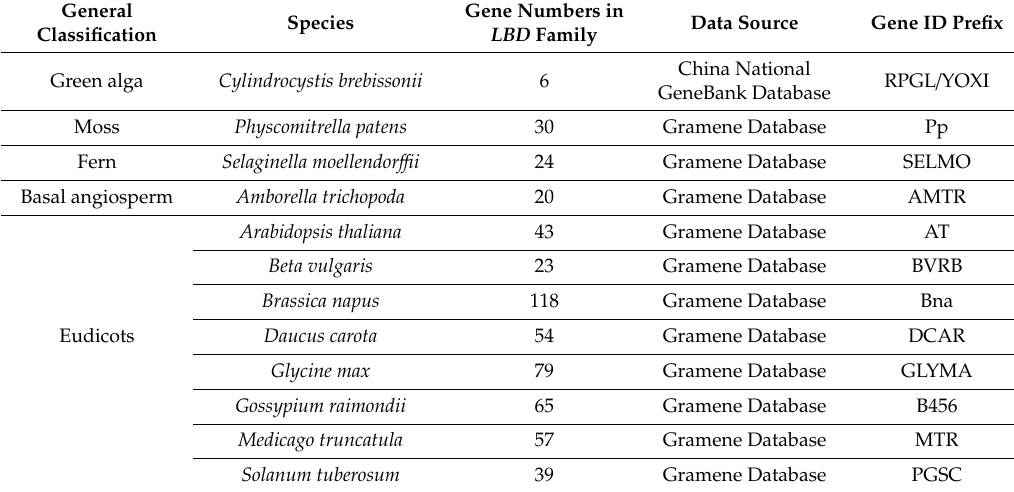
Table 1. Information on the 18 plant species for Lateral organ boundaries (LOB) domain ( LBD ) family